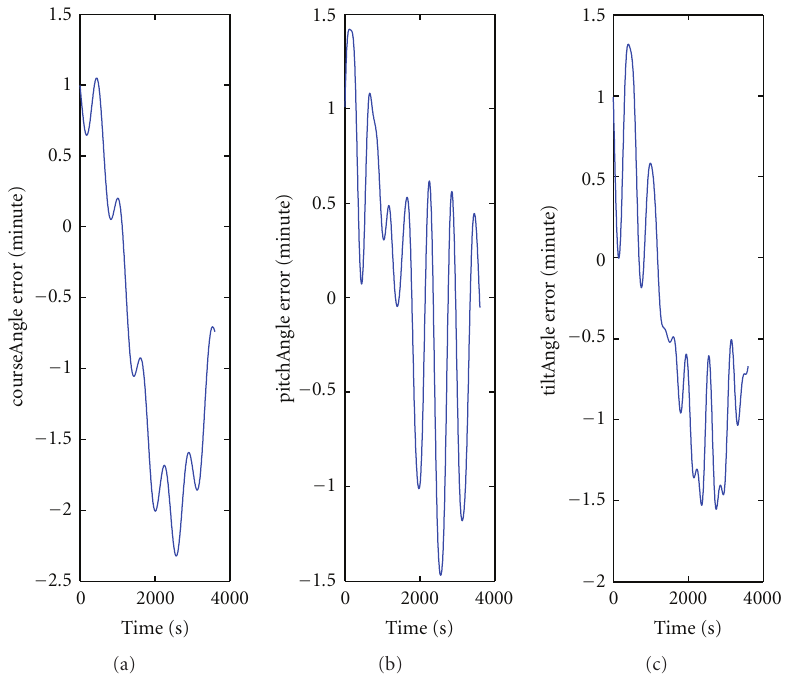
Figure 19: Angle error of s-shape